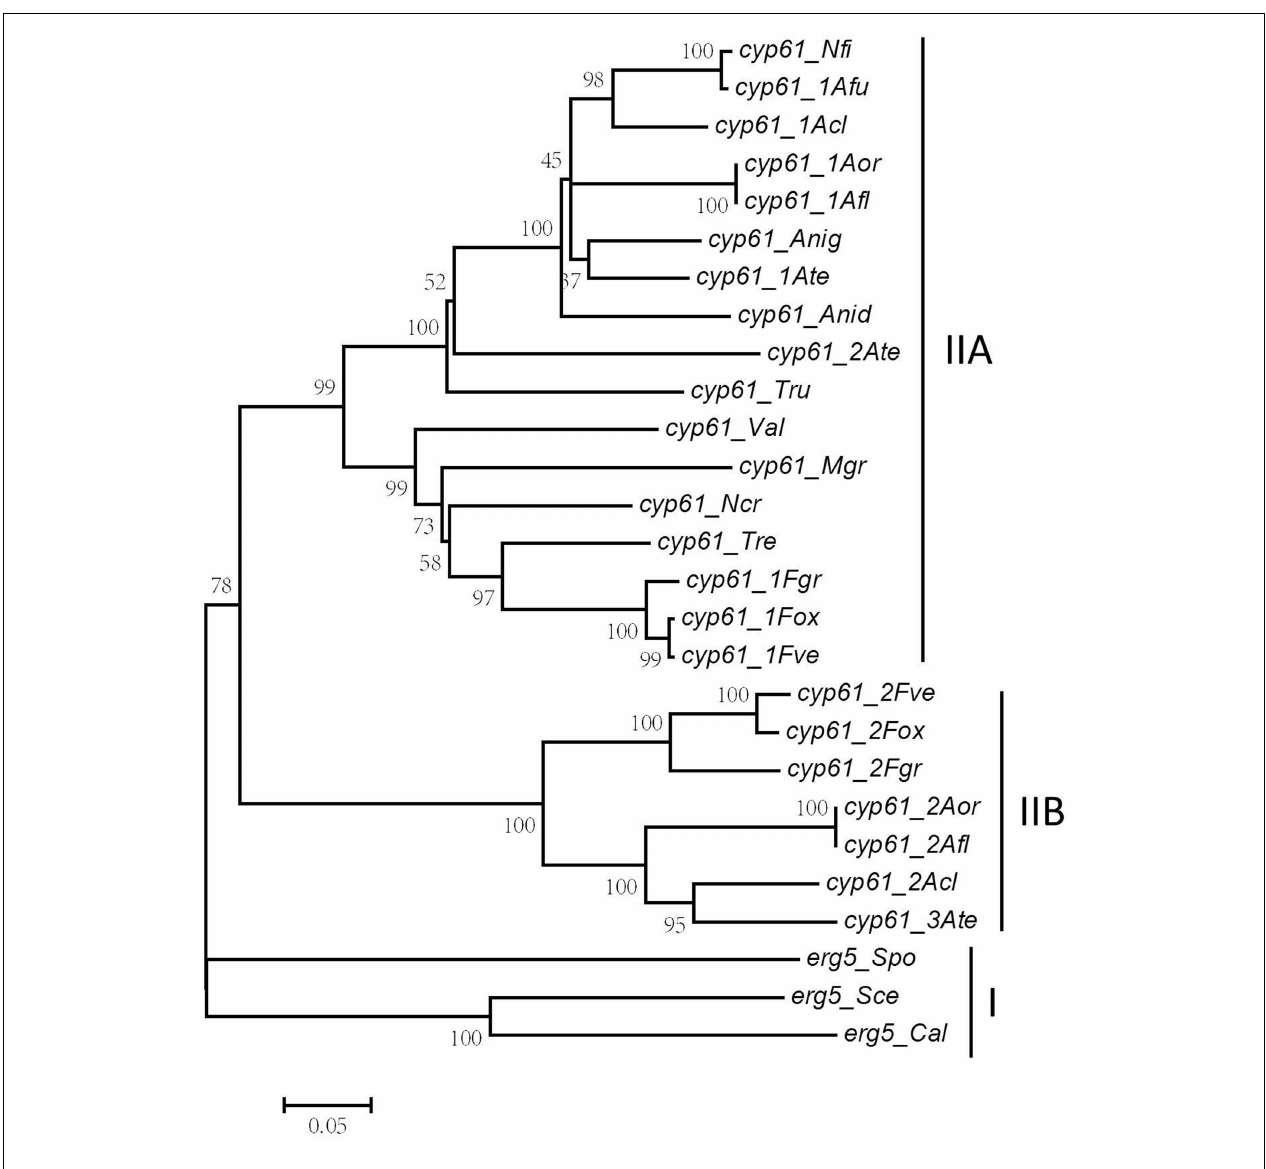
Spo , S. pombe ; Ncr , N. crassa ; Afu , A. fumigatus ; Afl , A. flavus ; Anid , A. nidulans ; Anig , A. niger ; Acl , A. clavatus ; Ate , A. terreus ; Aor , A. oryzae ; Nfi , N. fischeri ; Fve , F. verticillioides ; Fox , F. oxysporum ; Fgr , F. graminearum ; Tru , T. rubrum ; Val , V. albo-atrum ; Tre , T. reesei ; Mag , M. grisea